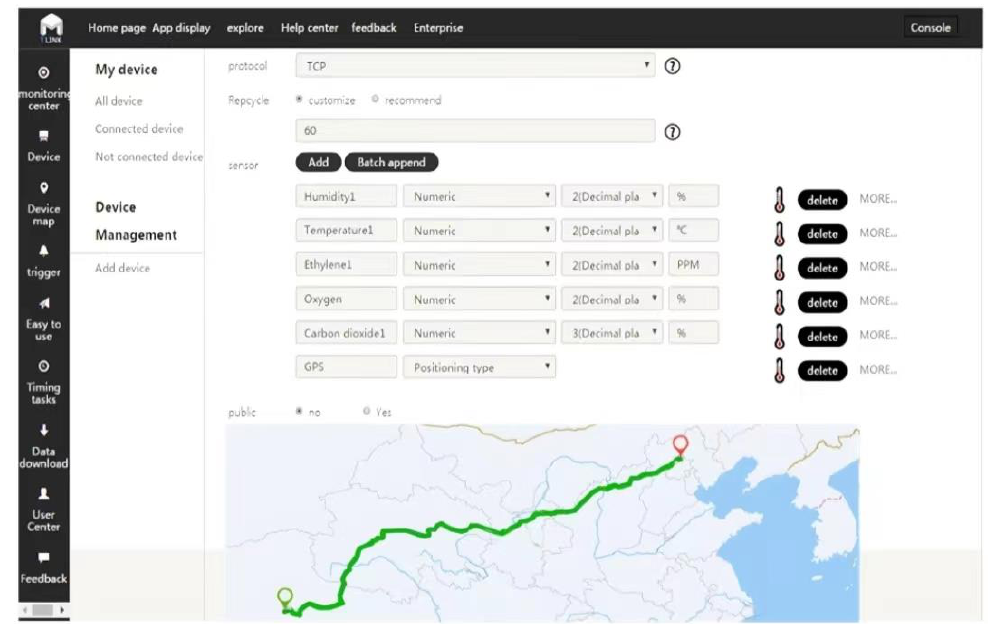
Figure 4. The interface of the matsutake cold chain real-time monitoring and tracing system.